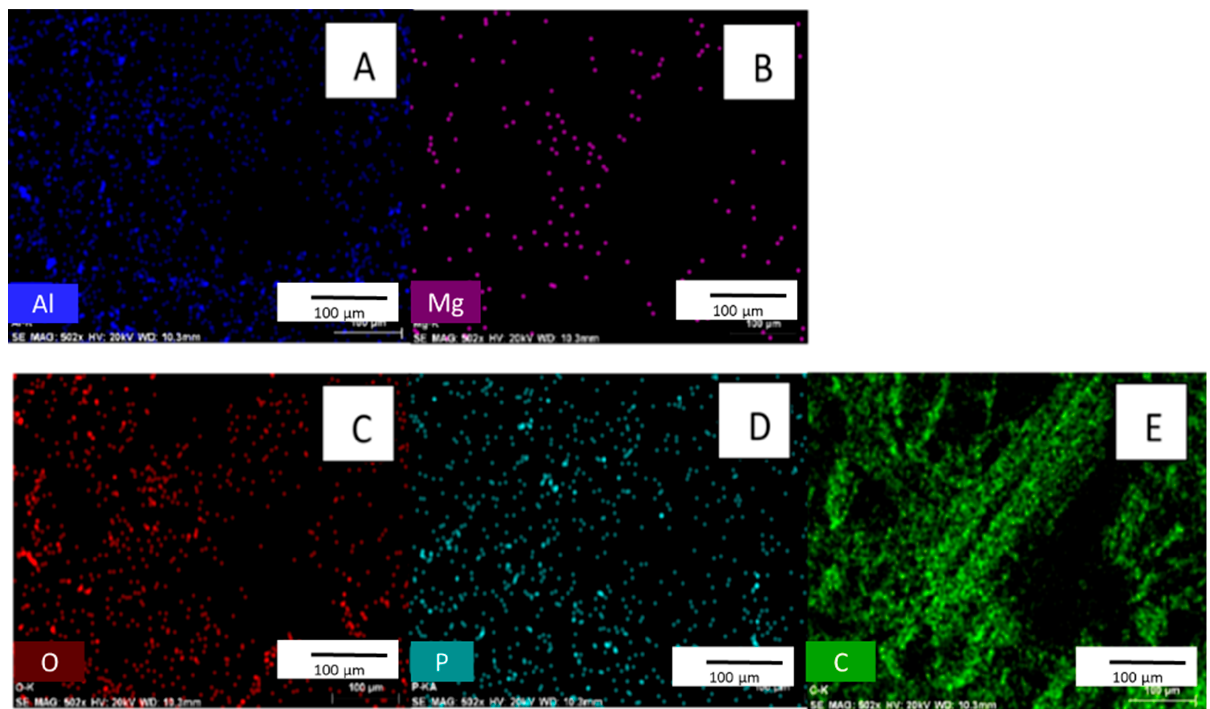
Figure 4. Images ( A – E ) are EDX surface scans of biochar after the adsorption of phosphate. [pH = 5.0; adsorbent concentration = 0.002 g/mL; 500 mg/L PO 4 3 − solution; shaking time 24